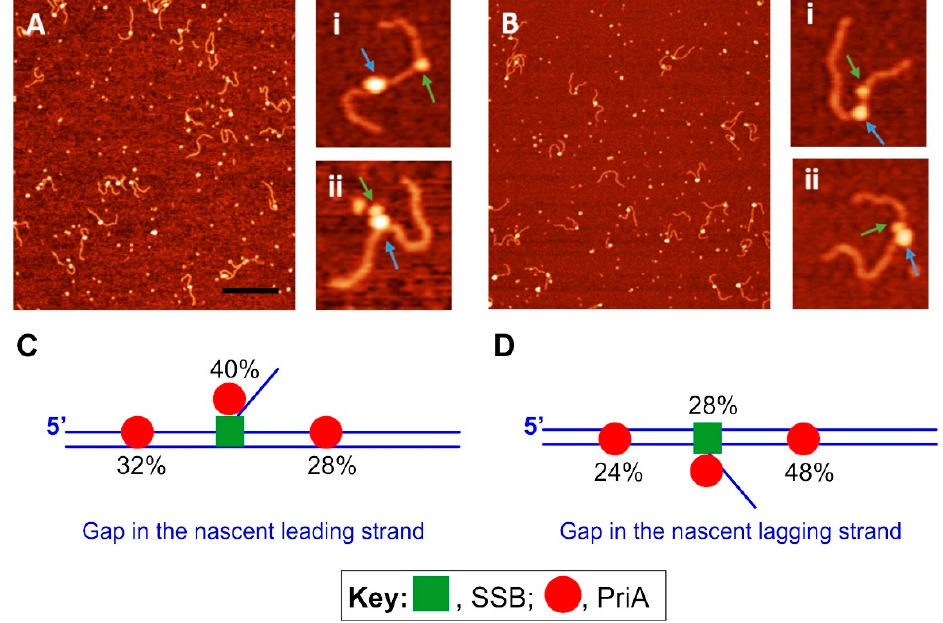
Figure 7. SSB loads PriA and remodels the helicase in the process. A and B , AFM images of PriA loading by SSB. The large blobs correspond to SSB (blue arrows) while the smaller ones correspond to PriA (green arrows). The insets in panels A and B are zoomed images. C and D , PriA locations following SSB loading and remodeling. The values represent the frequency of occurrence of PriA in each location. Adapted from reference [46].